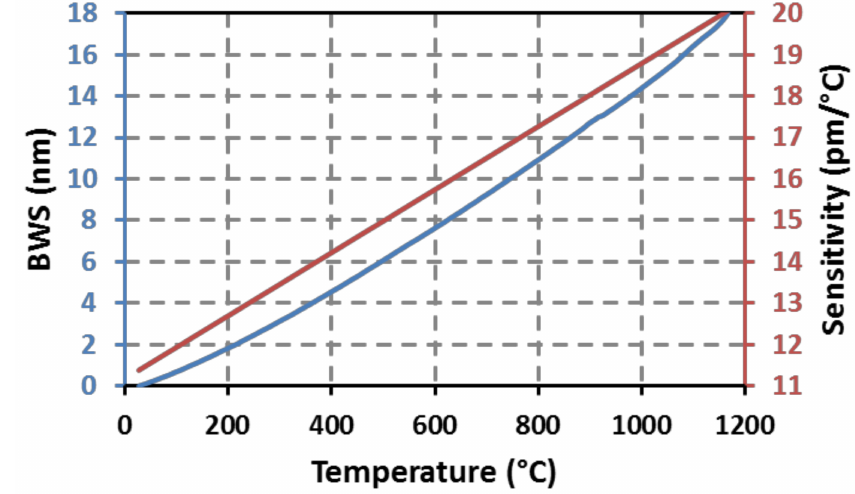
Figure 10. Calibration curve showing the Bragg Wavelength Shift (BWS) of a IR-fs-PbP FBG with respect to temperature and evolution of its thermal sensitivity according to the operating